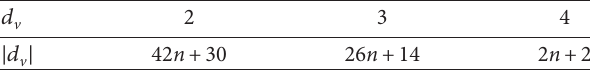
Table 1: Partitions of H ’s vertices according to the degree.